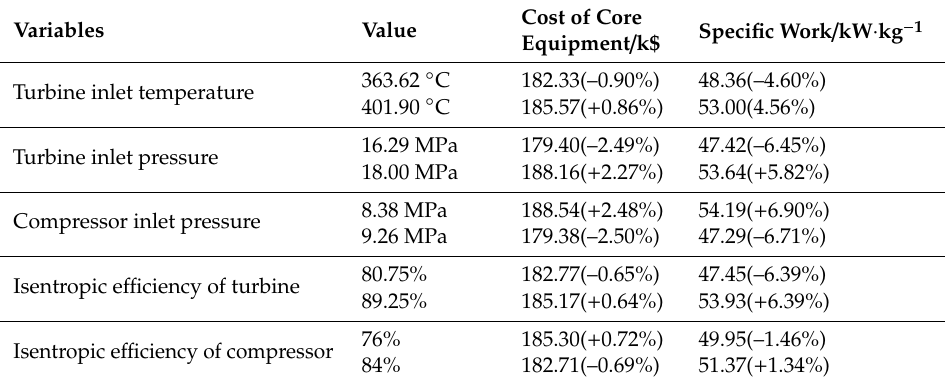
Table 7. Sensitivity analysis